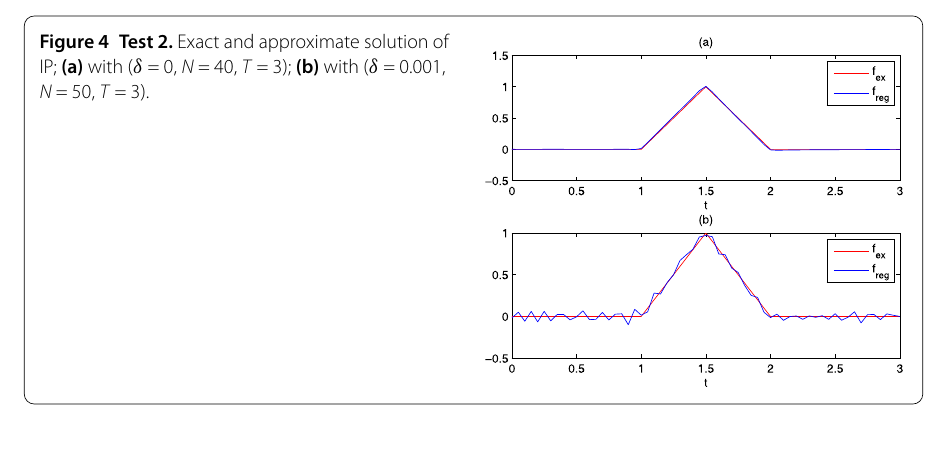
Figure 5 Test 2. Exact and approximate solution of IP with parameters ( δ = 0.01, N = 30, T = 5); (a) without mollification; (b) with mollification ν =